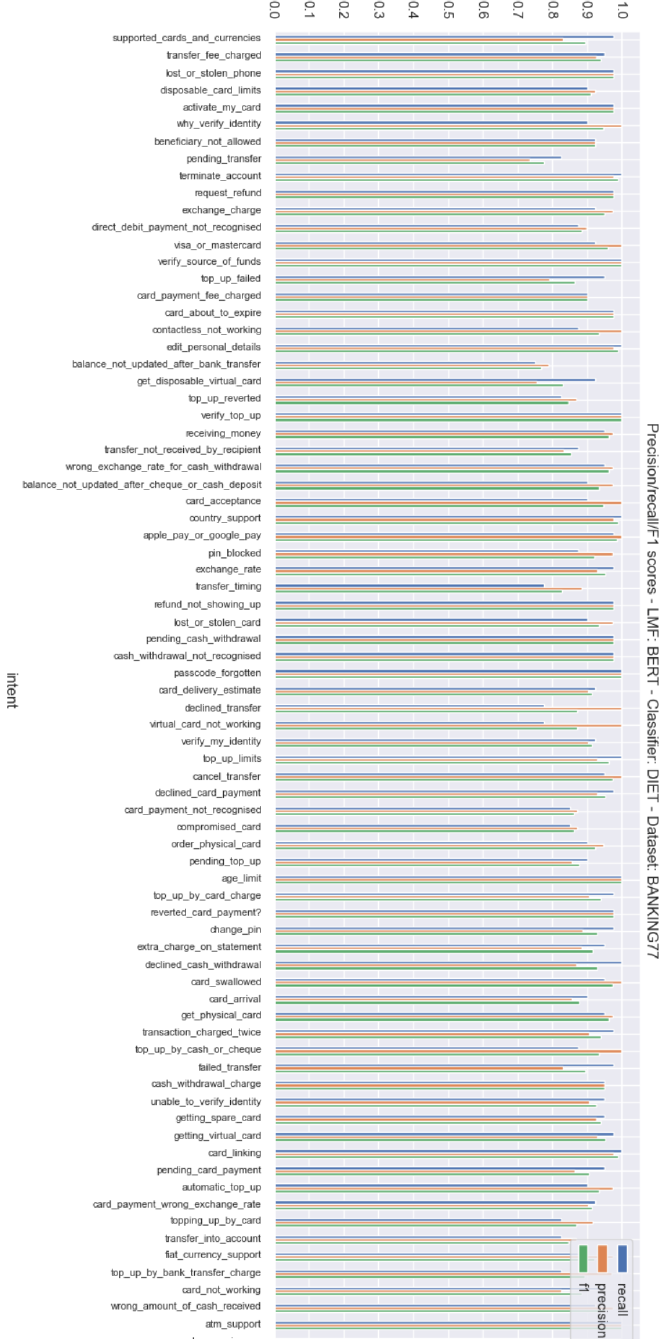
Figure A1. Recall, precision, and F1 scores obtained for intent classification on the BANKING77 test set using the BERT model as a language